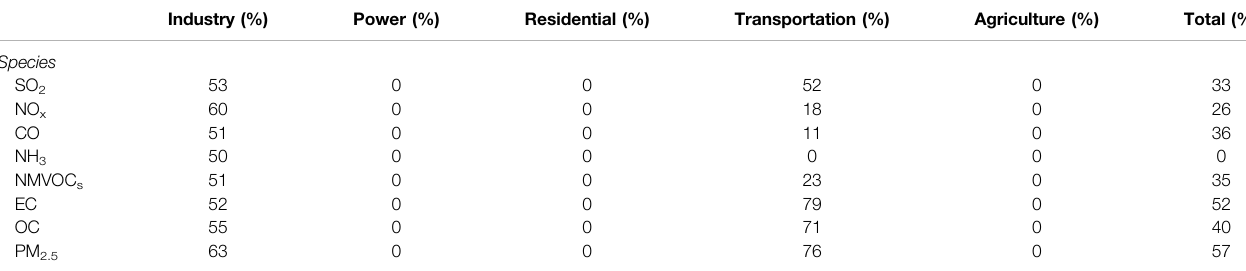
TABLE 1 | Reductions of the air pollutant emissions in Nanjing during the First Jiangsu Development